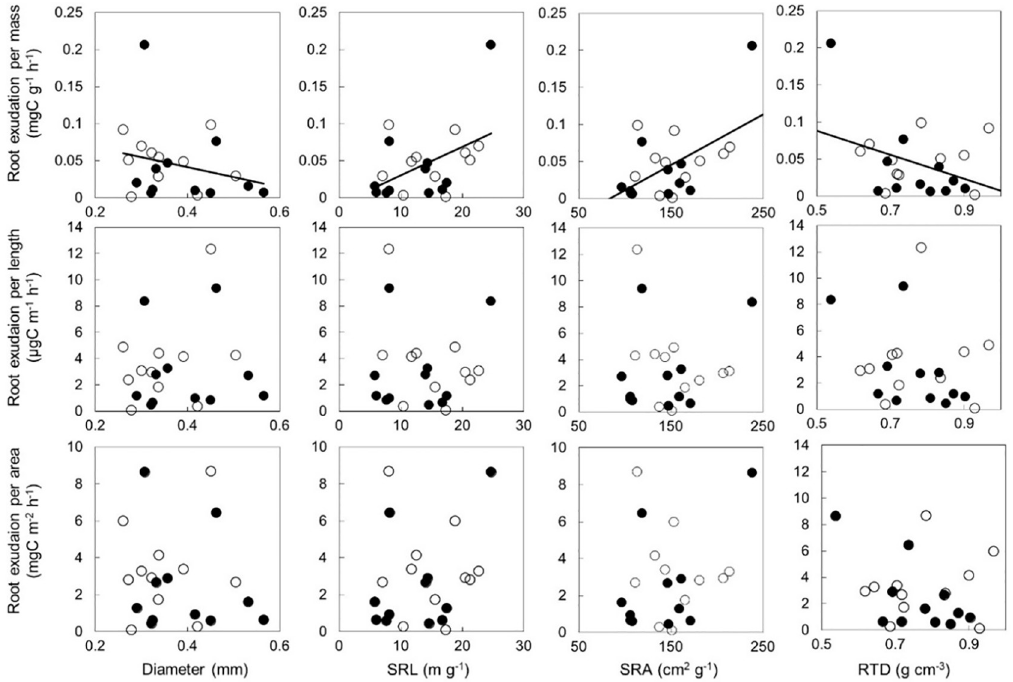
Fig 1. Relationships between diameter, specific root length (SRL), specific root area (SRA), and root tissue density (RTD) with root exudation per mass, length, and surface area. Correlations between exudation per mass and morphological traits were significant, whereas others were not. Unfilled and filled circles indicate upper and lower plots on slope, respectively.